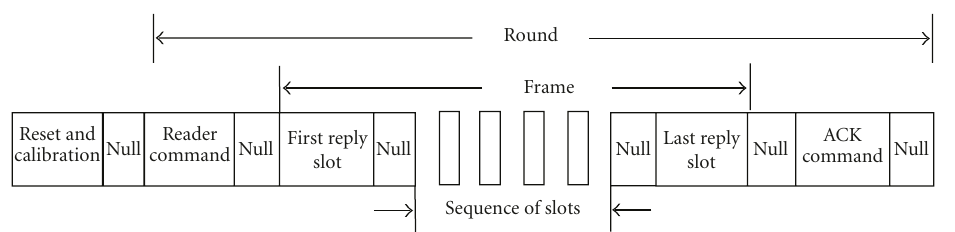
Figure 1: Round structure of